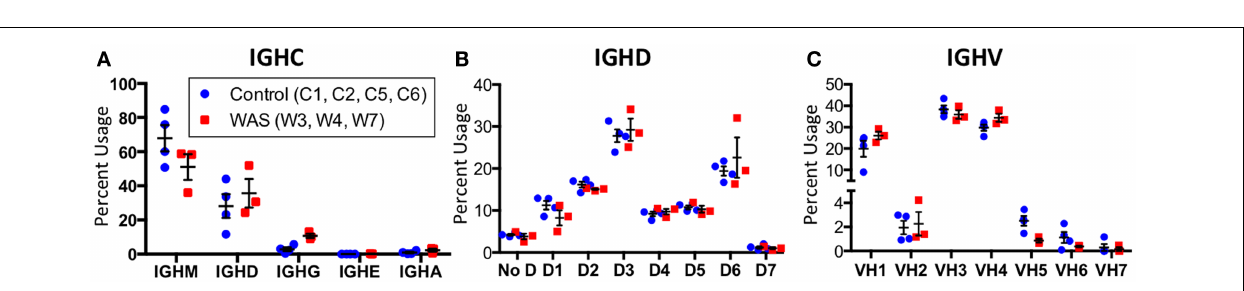
FIGURE 9 | Clonal expansion of the IGH repertoire in circulating CD19 + lymphocytes . (A) The relative frequency of the 100 most abundant clones is displayed as a proportion of the total sequences in four healthy controls (C1–C4) and threeWAS patients (W3,W4, andW7). The black line indicates the mean of the sample. (B) The degree of clonal expansion for each patient’s repertoire is displayed by plotting the cumulative percentage of unique clones ( x ) vs. the cumulative percentage